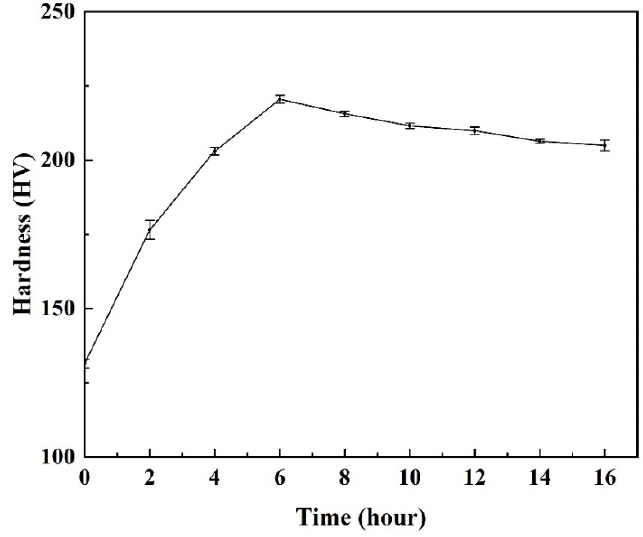
Figure 8. Aging curves of the Al-5Cu-Li-Mg-Ag-Mn alloys. Microstructure and phase composition of the peak-age alloys was investigated.